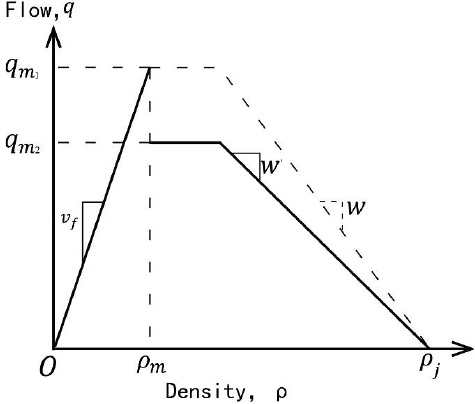
Figure 2. Flow-density relationship under sudden drop of merging cell capacity.